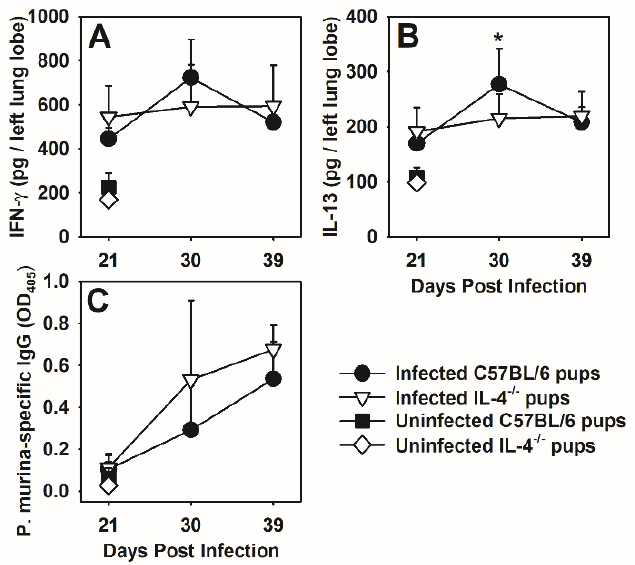
Figure 5. The absence of IL-4 does not significantly alter lung IFN γ levels or P. murina -specific serum IgG. Two-day-old C57BL/6 and IL-4 − / − pups were infected with 5 × 10 5 P. murina organisms/g body weight. At indicated days post infection, lung homogenates were analyzed for ( A ) IFN γ and ( B ) IL-13 levels in the left lobes by ELISA. ( C ) Serum P. murina -specific IgG was analyzed by ELISA. Data represent the mean ± SD of 4–7 mice and are representative of 2 experiments. * p < 0.05 compared to IL-4 − / − pups at the same time point.